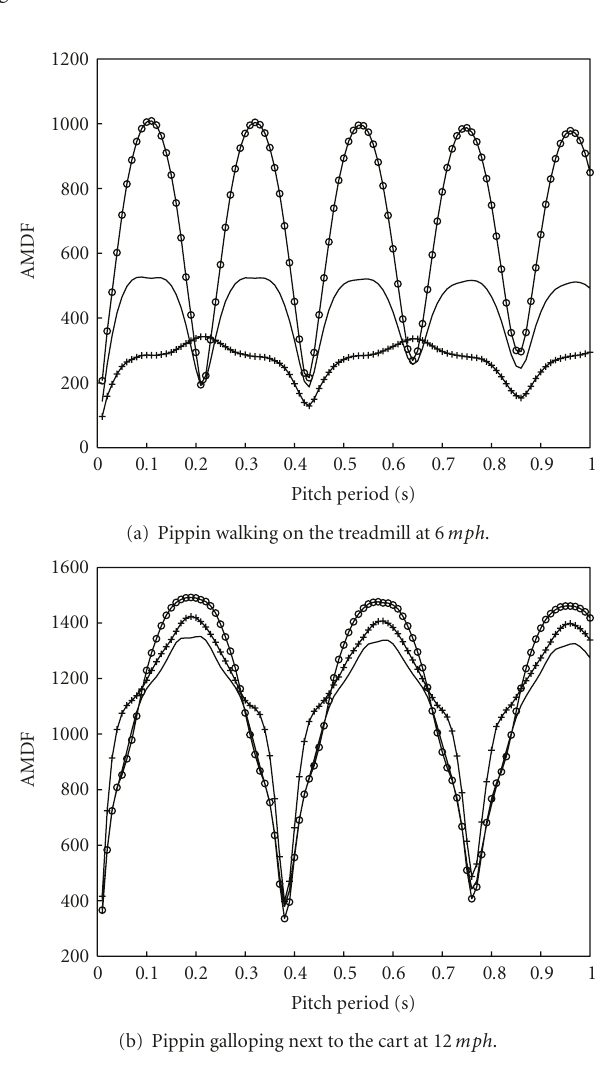
Figure 14: AMDF functions for accelerometer trials with